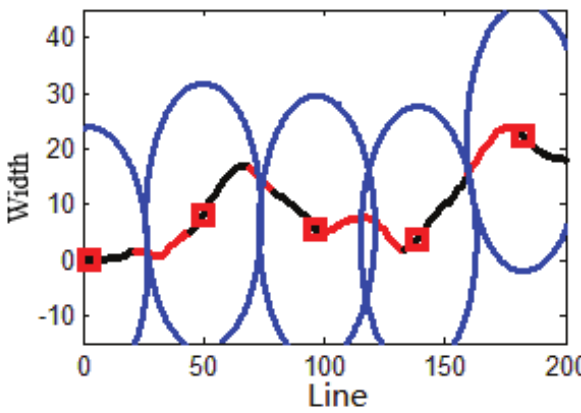
Figure 19: Case 4: The optimal complicated tunnels by ECO